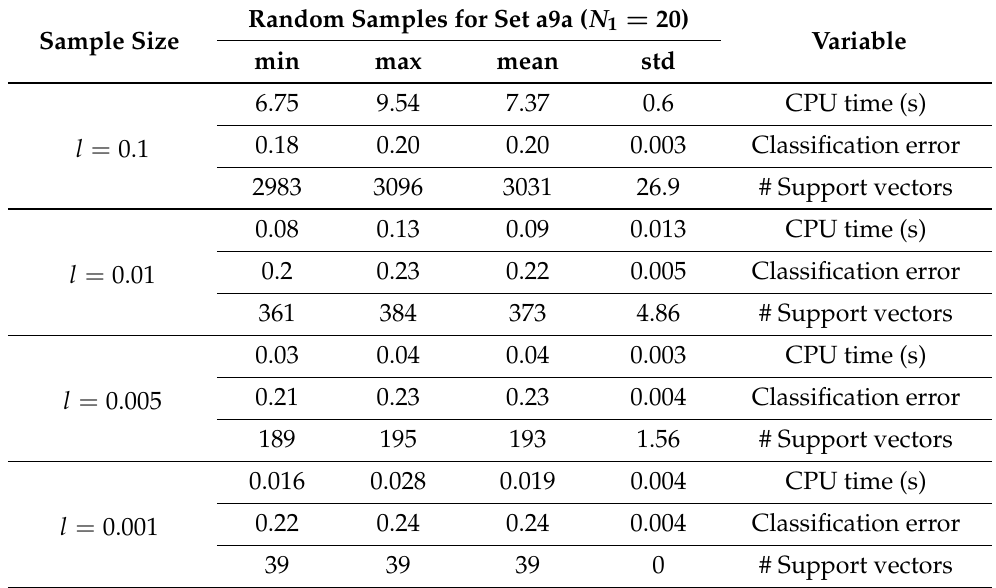
Table 4. Random samples baselines for set a9a. As sample size increases, error is smaller but number of SV increase. Total error for l = 0.1 is essentially equal to results for LSH-SVM Algorithm 2, but number of SV is consistently